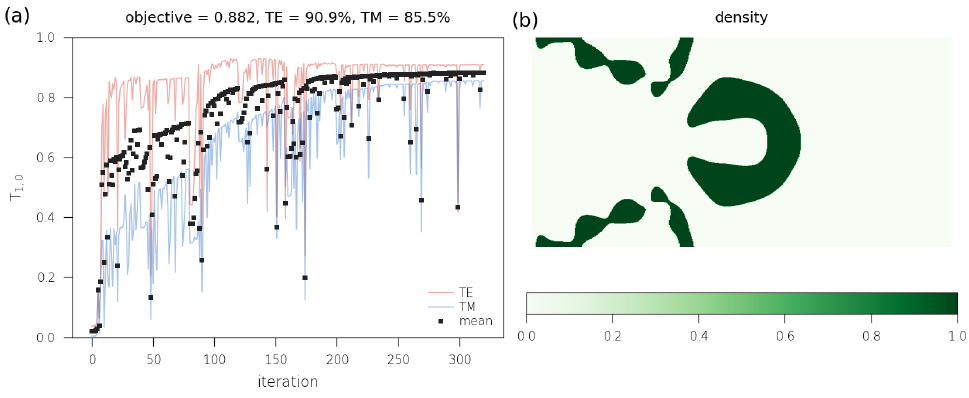
Figure 3. Optimized metasurface blazed in the ( 1,0 ) transmitted order. ( a ): optimization history showing the figure of merit Φ (black squares) and the transmission coefficient for TE (blue line) and TM (red line) polarization. The final metagrating has 90.9% and 85.5% transmission efficiency for TE and TM polarized waves, respectively. ( b ): optimized density function (0 corresponds to air and 1 to